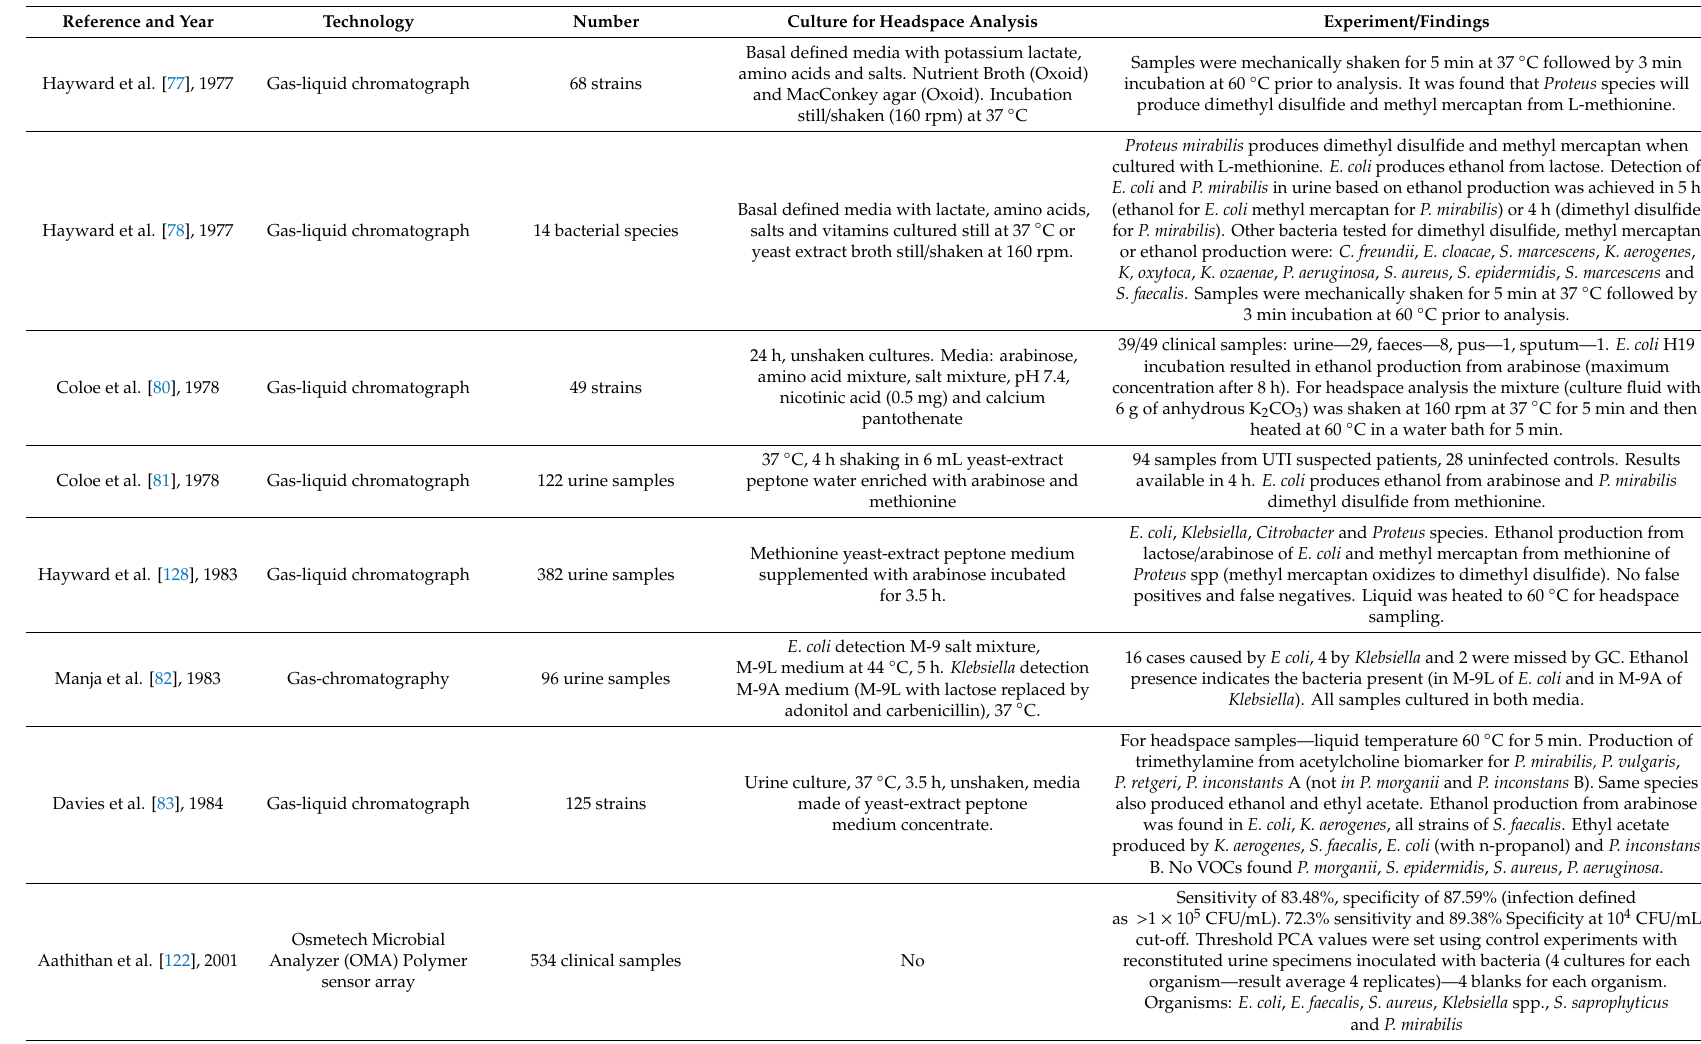
Table 3. Urinary Tract Infection and Pathogen Volatile Organic Compounds